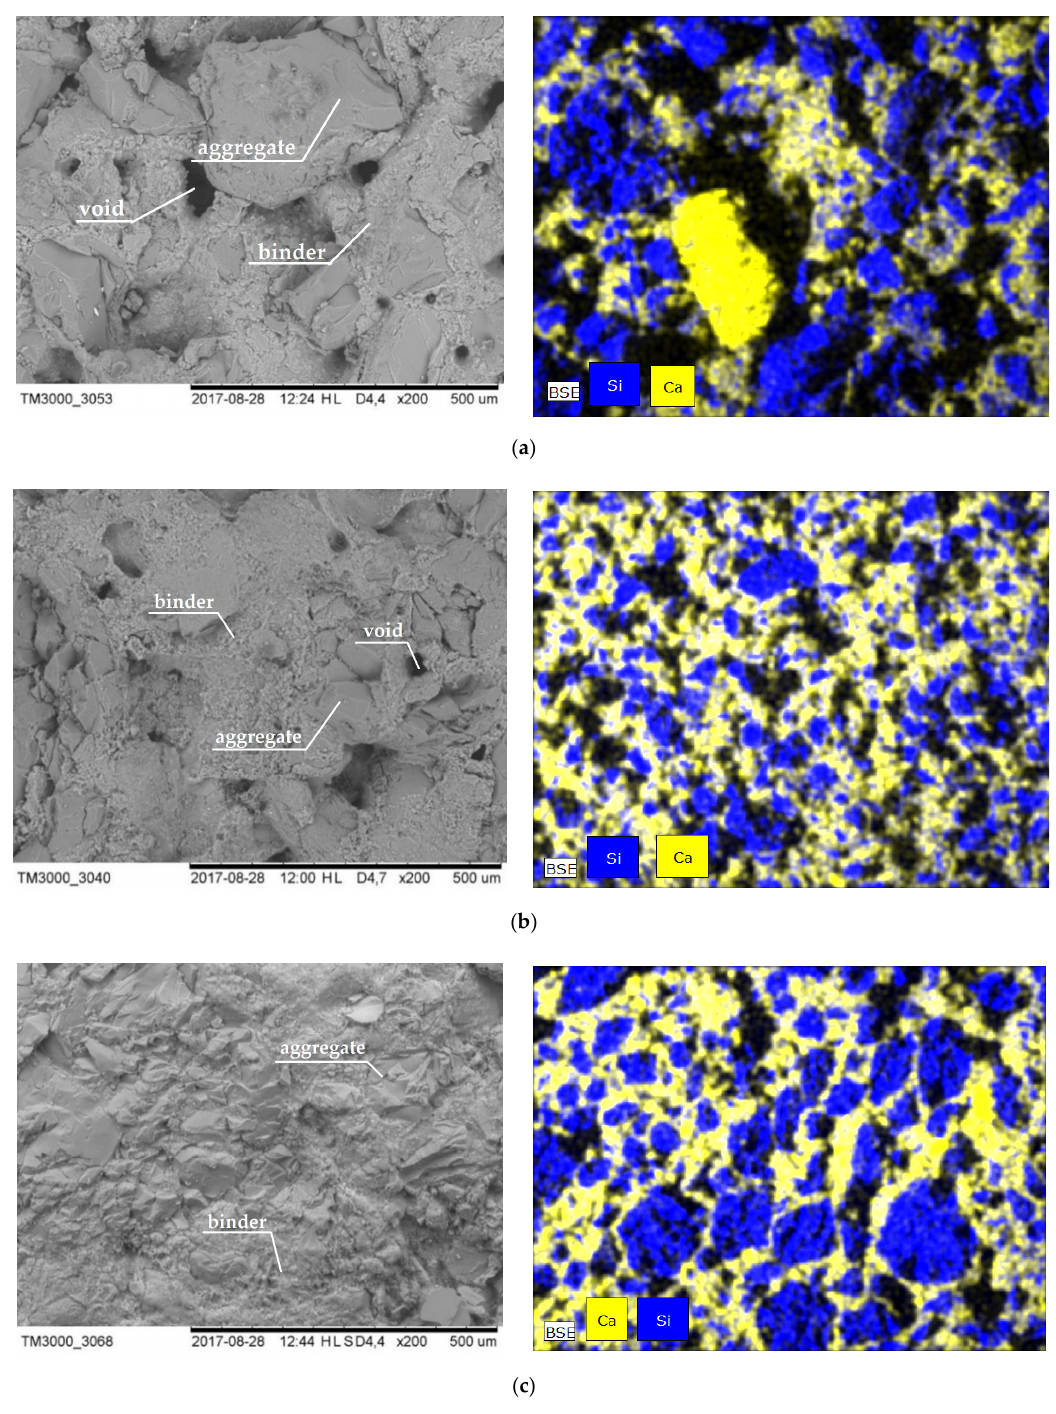
Figure 7. SEM (Scanning Electron Microscopy) images ( left ) of individual silicate samples at ×200 magnification: ( a ) CS-E, ( b ) CS-X, ( c ) CS-B and the EDS (Electron Dispersive Spectroscopy) results ( right ).